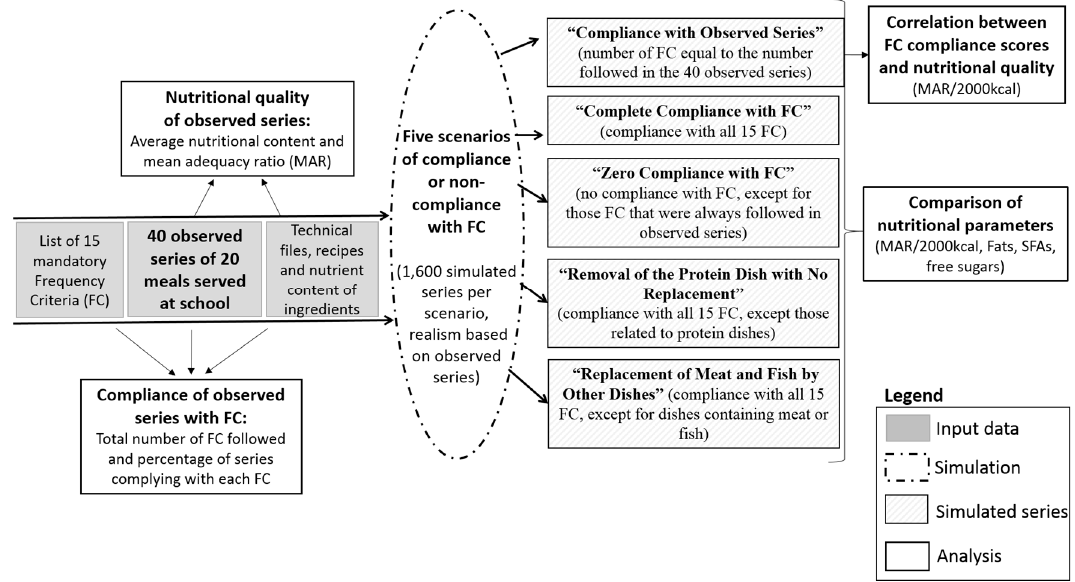
Figure 1. Overview of the methodology used to generate simulated series of 20 consecutive meals (based on 40 observed series), according to five scenarios of compliance and non-compliance with the 15 frequency criteria (FC) in French school food guidelines. Table 1. The 15 frequency criteria for school meal service in France [10,13] and the percentage of series fulfilling each criterion among the 40 observed series of 20 meals.